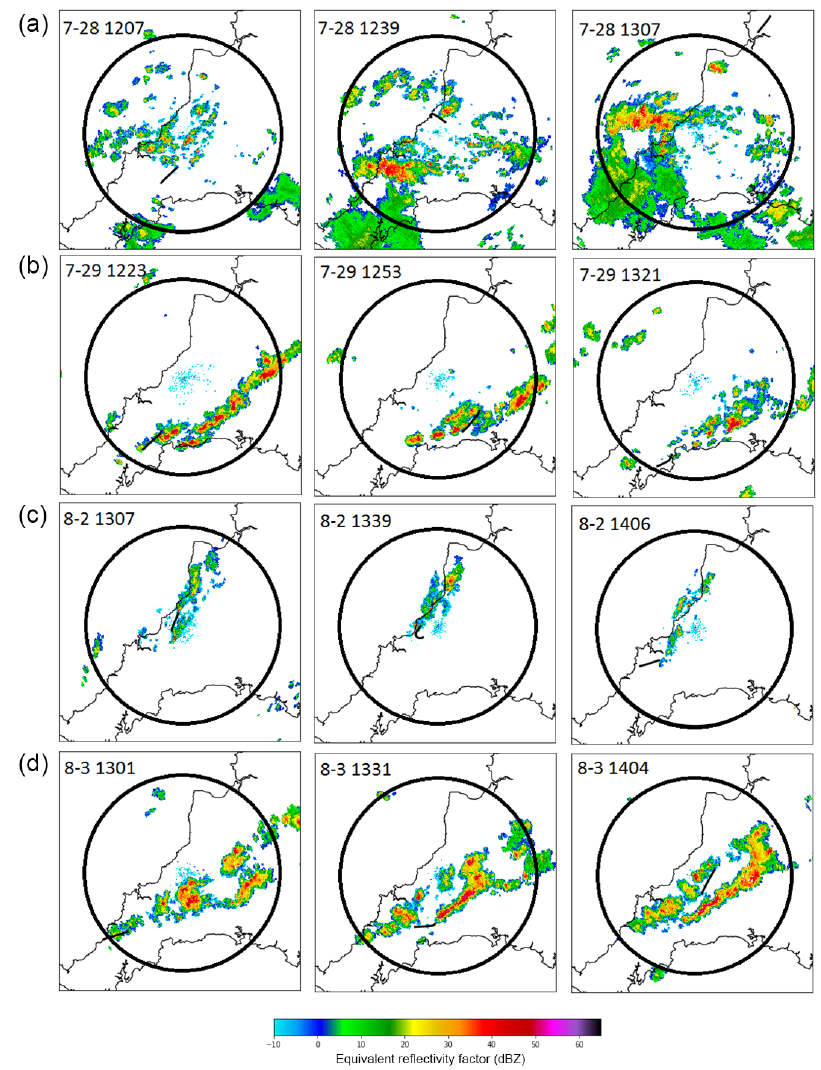
Figure 1. Reflectivity factor from the 3.5 ◦ elevation scan from NCAS radar for three times during a 1h period on each of the study days. Row (a) shows scans from Case A (28 July), Case B (29 July) in (b) , Case C (2 August) in (c) , and Case D (3 August) in row (d) . The times on each day correspond roughly to the time period centered on the flight of the UWKA. Range rings are shown for 50km centered on the radar. The thick black line indicates the flight path of the UWKA for a 15min period centered on the time of the radar